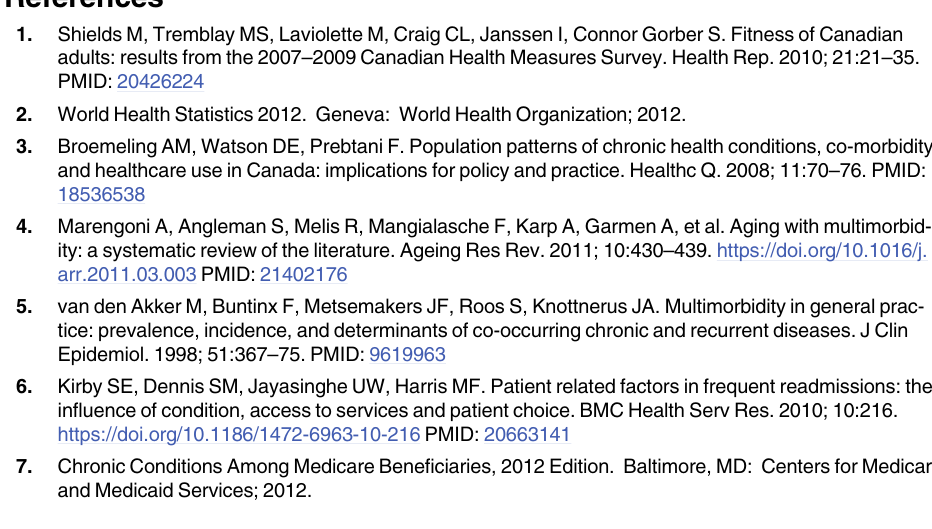
S4 Fig. Specialist referrals (n = 282). � Other includes: hematology, ENT, pain management, allergy, plastic surgery, pediatrics, nephrology, ophthalmology and respirology.